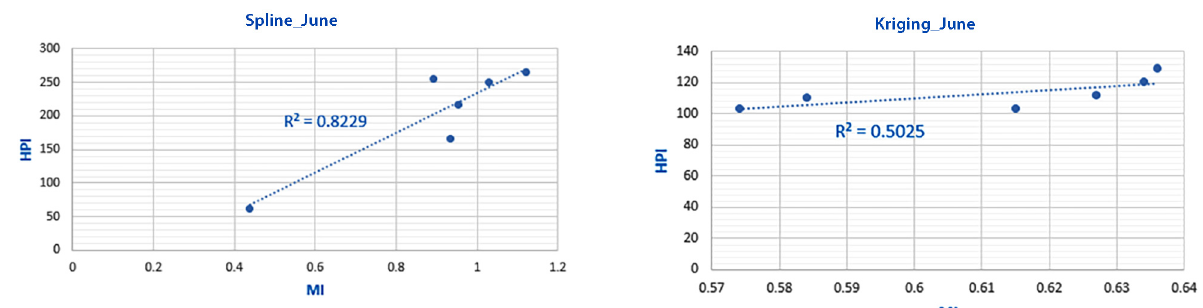
Figure 9. Correlation analysis of June, 2018 (Spline and Kriging)